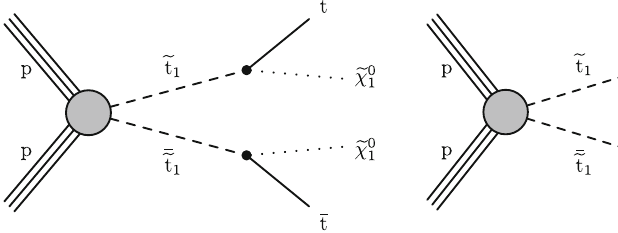
.Thedecayoftheintermediate ˜ χ ± intoaWbosonanda ˜ χ 0 1 a ν , plus a ˜ χ 0 and a (cid:5) ± from the decay of an intermediate slepton (cid:2) (cid:5) ± , 1 is described by the T8bb (cid:5)(cid:5)νν model that further decays 1